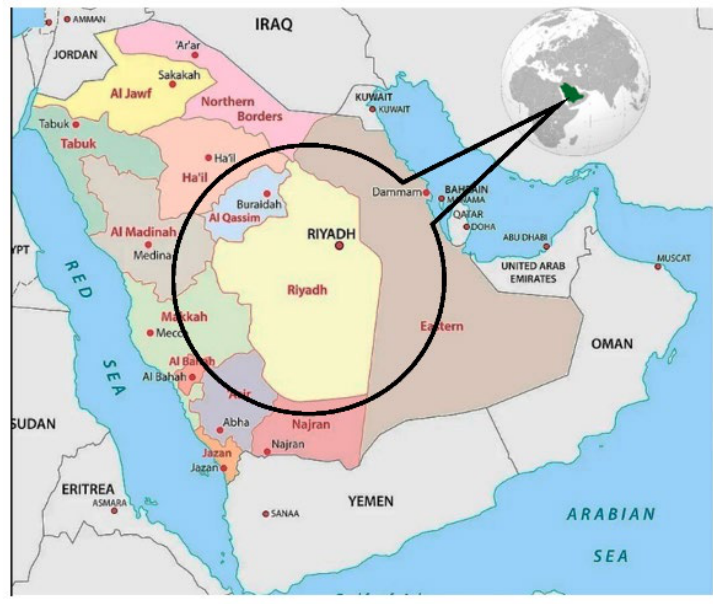
Figure 3. Location of Riyadh, Saudi Arabia, on a world map.